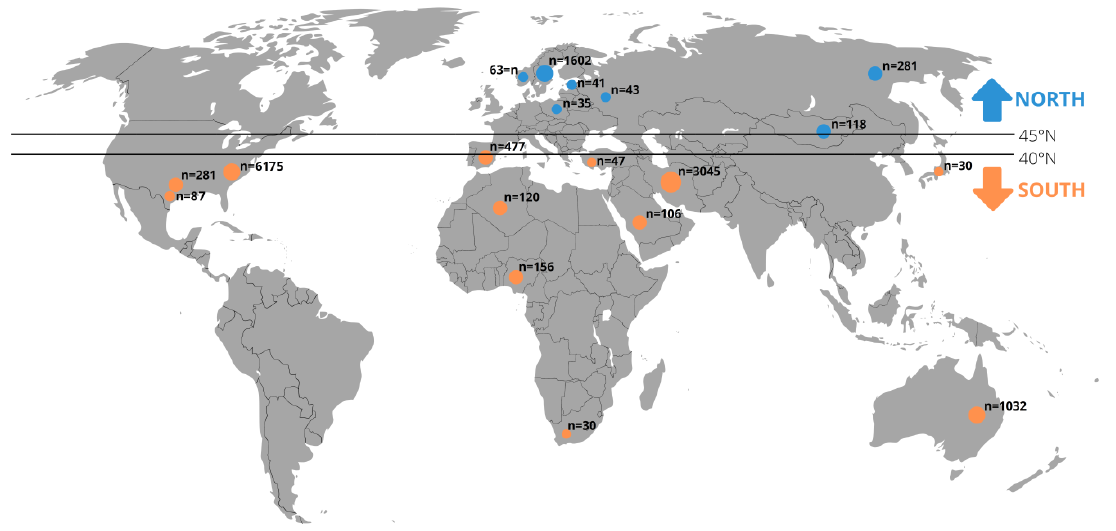
Figure 1. The 13,320 individuals divided into the “North” and “South” subgroups included in the